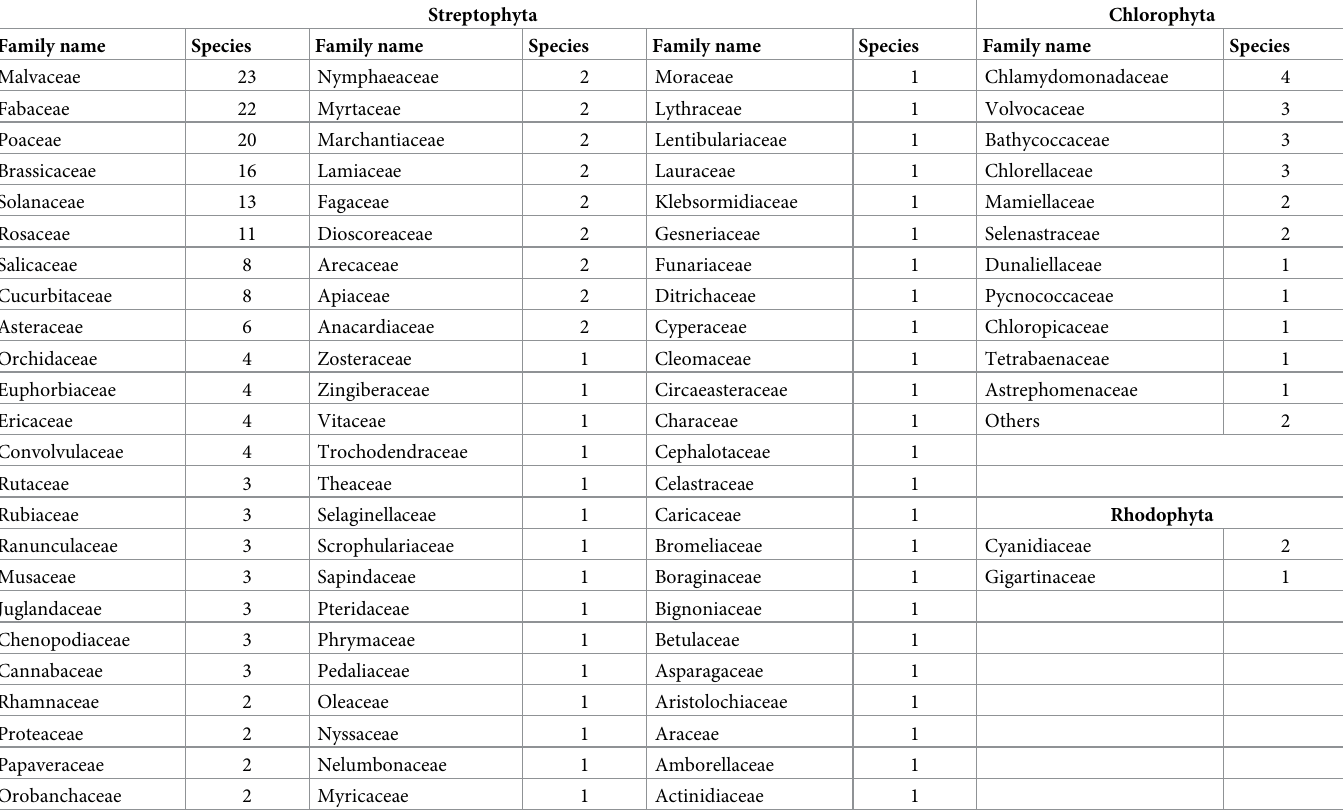
Table 2. List of plant family names and total number of species used in the present study.